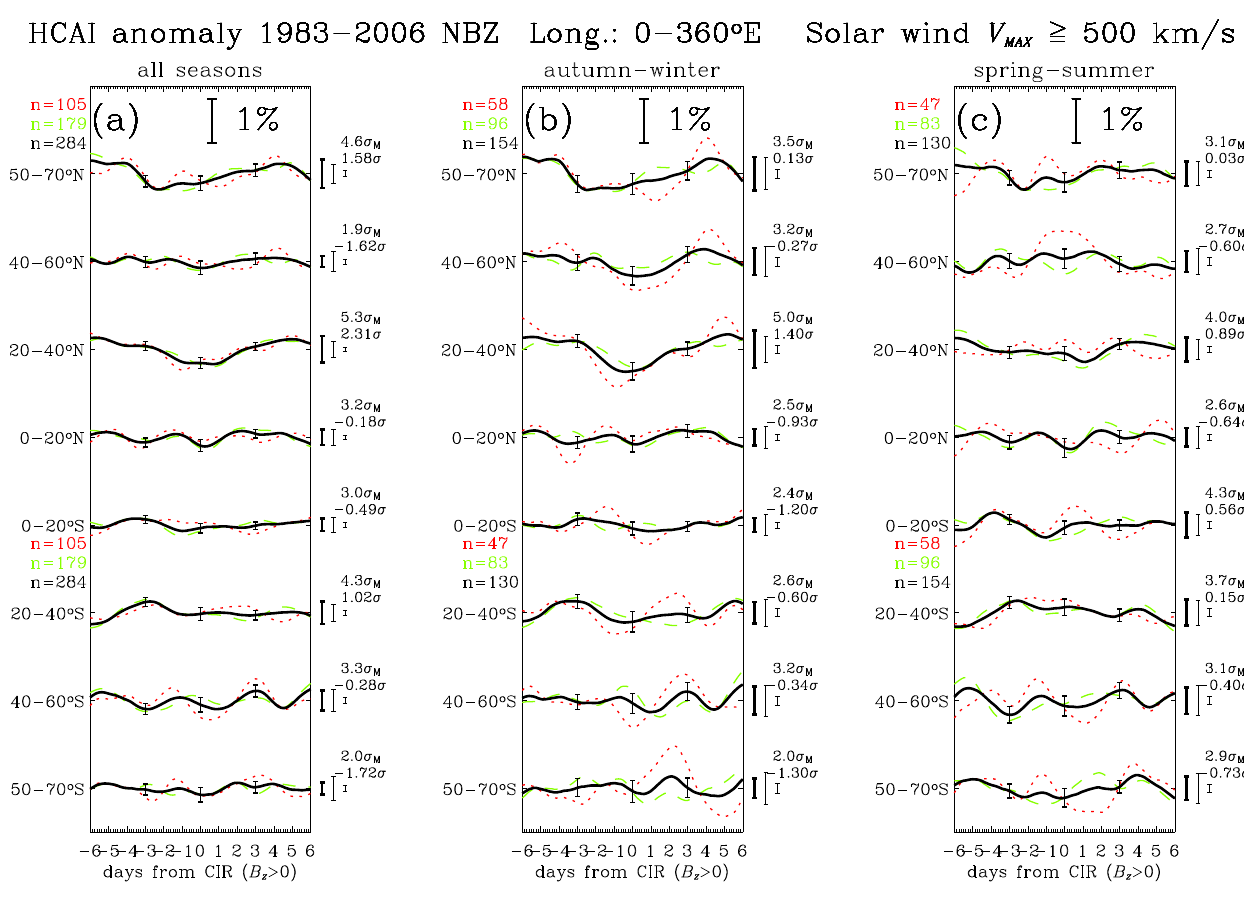
> 0). Fig. 14. The same as Fig. 12 but for NBZ events (IMF B Z > 0). Z